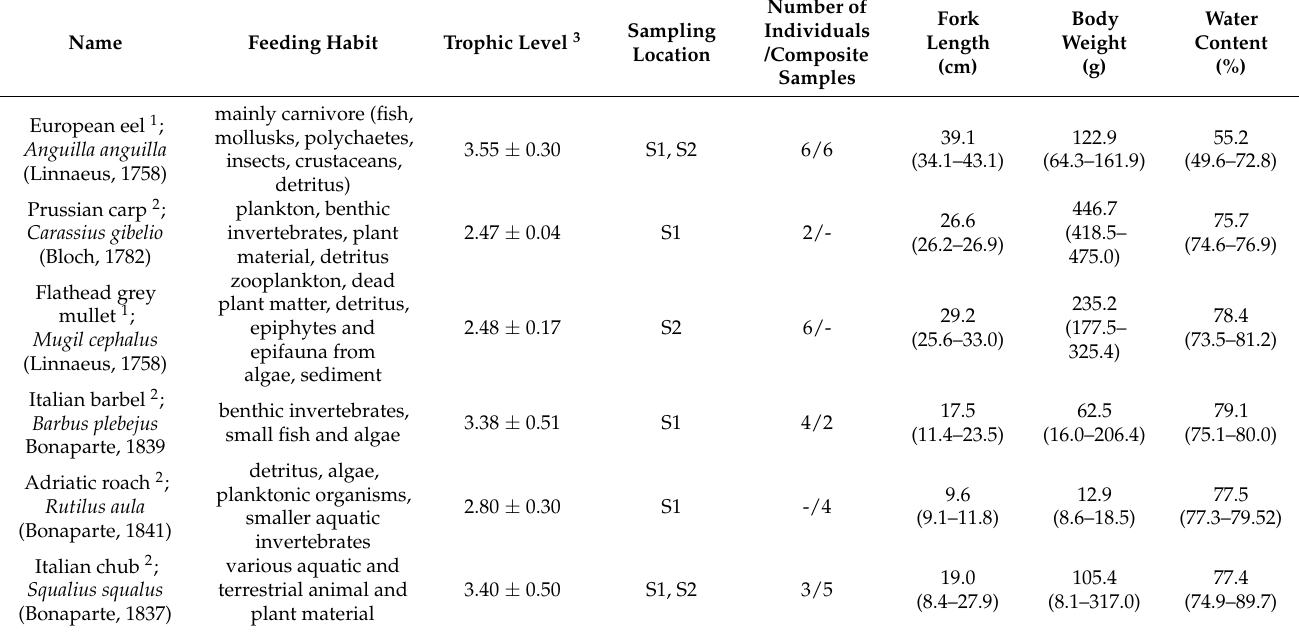
Table 1. Basic parameters of the six fish species collected at two locations in the Raša River. Data for fork length, body weight and water content are presented as median